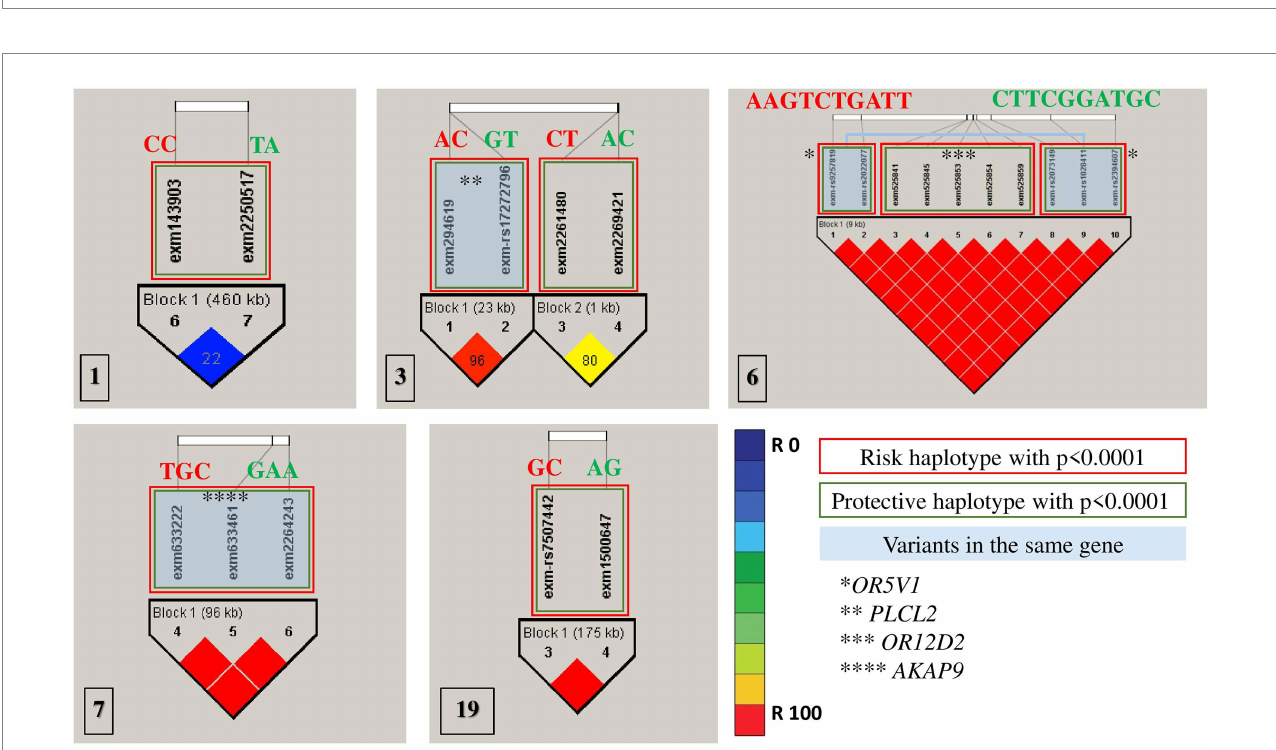
FIGURE 2 Haplotype blocks representing the linkage disequilibrium of chosen SNPs on chromosomes of autistic females in Saudi Arabia. The numbers at the bottom left of each picture correspond to the chromosome number. * refers to the genes’ names. Red rectangles are the most risk haplotypes, green rectangles are the most protective haplotypes and light blue rectangles highlights the SNPs which are located in the same gene. Further details are in Table